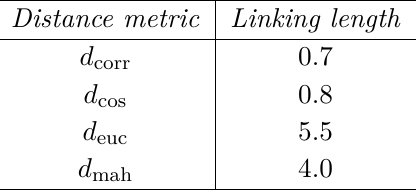
Table 4. Linking length values used for each distance metric for our prototype stop